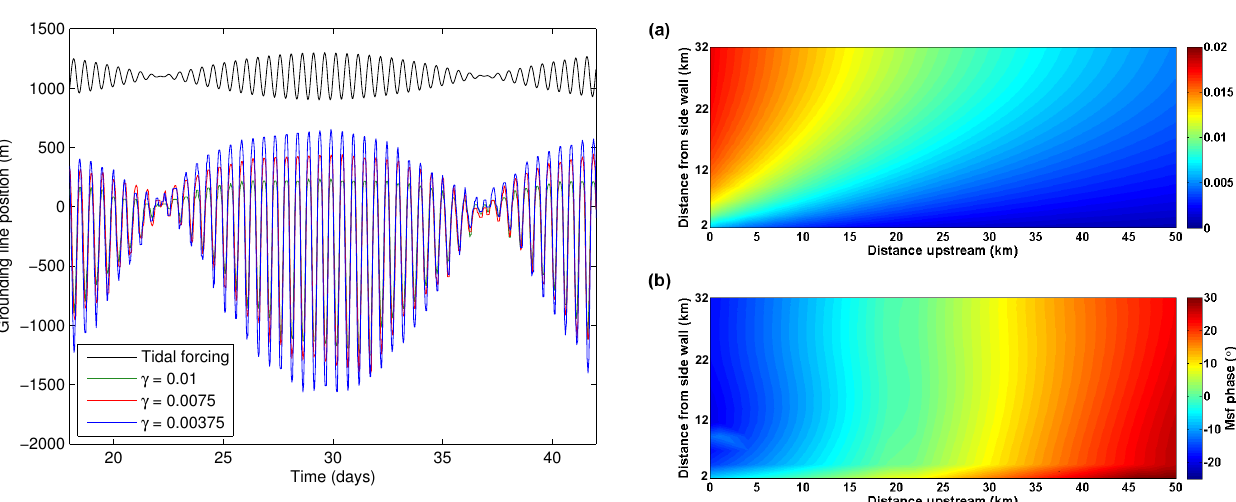
Figure 6. Plots showing amplitude (a) and phase (b) of the Msf tidal constituent based on tidal analysis of detrended horizontal surface